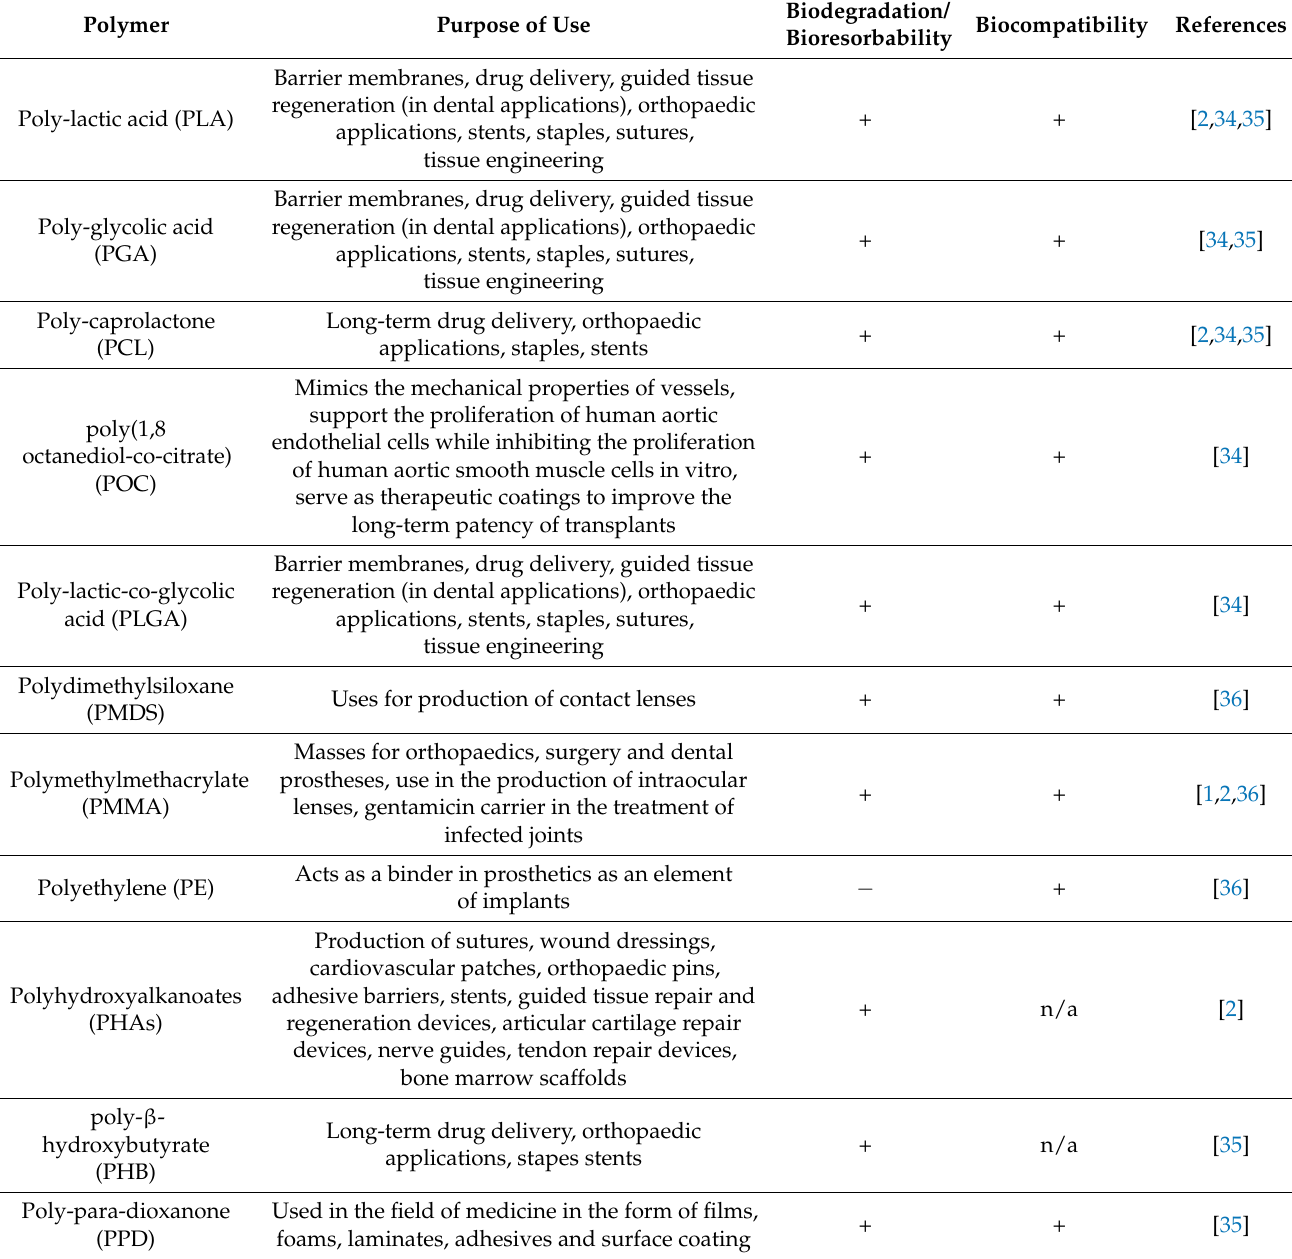
Table 1. Polymers for medical and dental